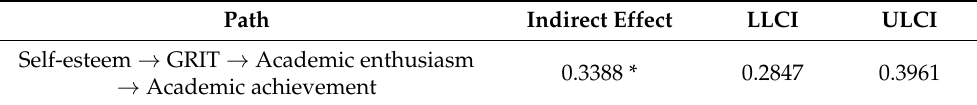
Table 5. PROCESS macro analysis